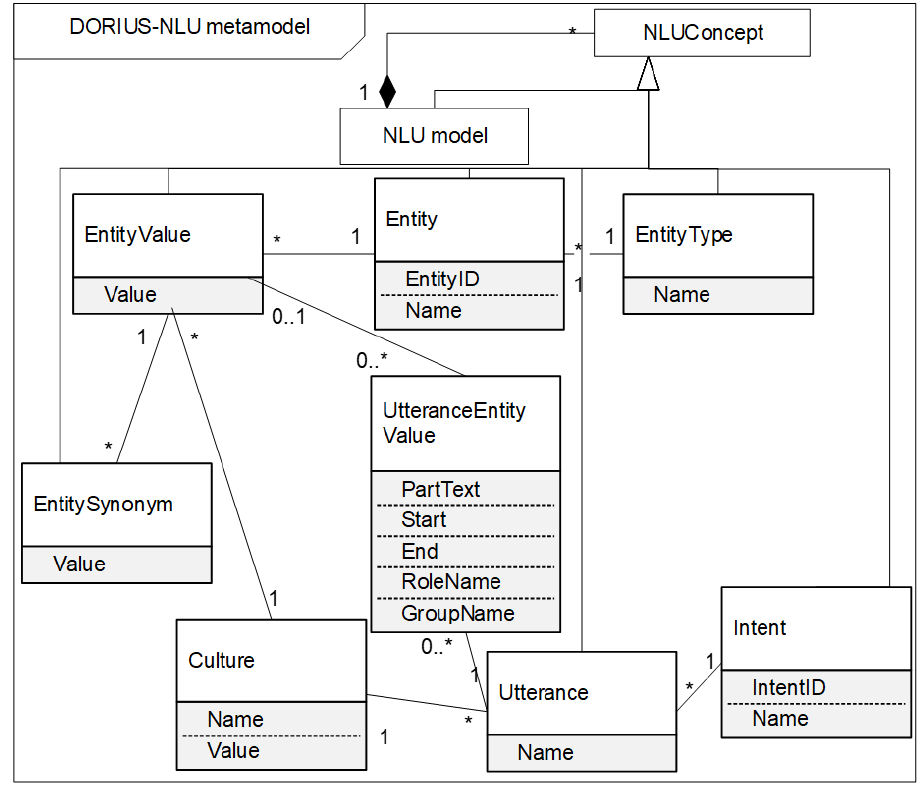
Figure 3. DORIUS